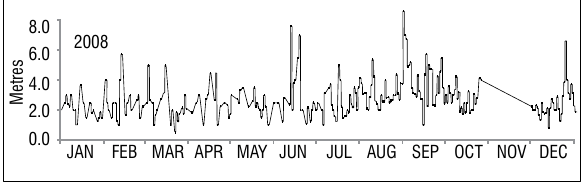
Figure 8: Daily significant wave heights from voluntary observing ships data for 2008. The dots indicate the values of wave height, joined by the thin line. There are numerous days when there were no